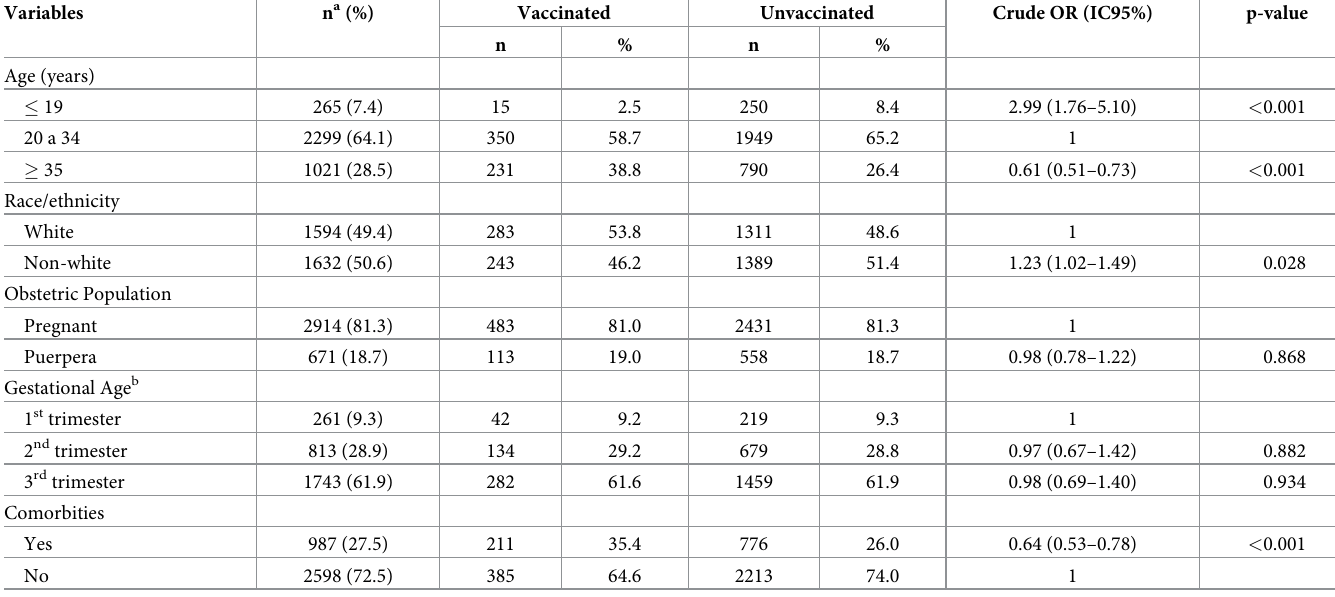
Table 1. Univariate analysis of demographic, ethnic-racial, obstetric characteristics and comorbidities of pregnant and postpartum women with SARS according to the vaccination status against Covid-19. Brazil, 2021.